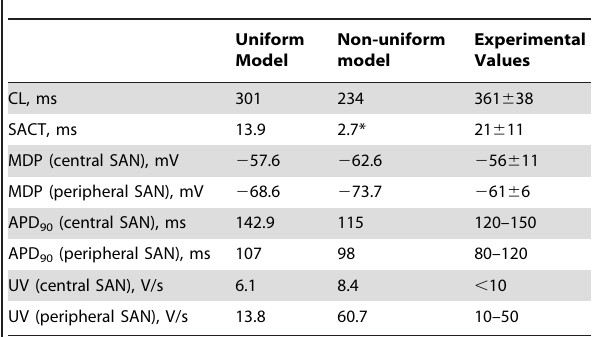
Table 1. Comparison of intact SAN